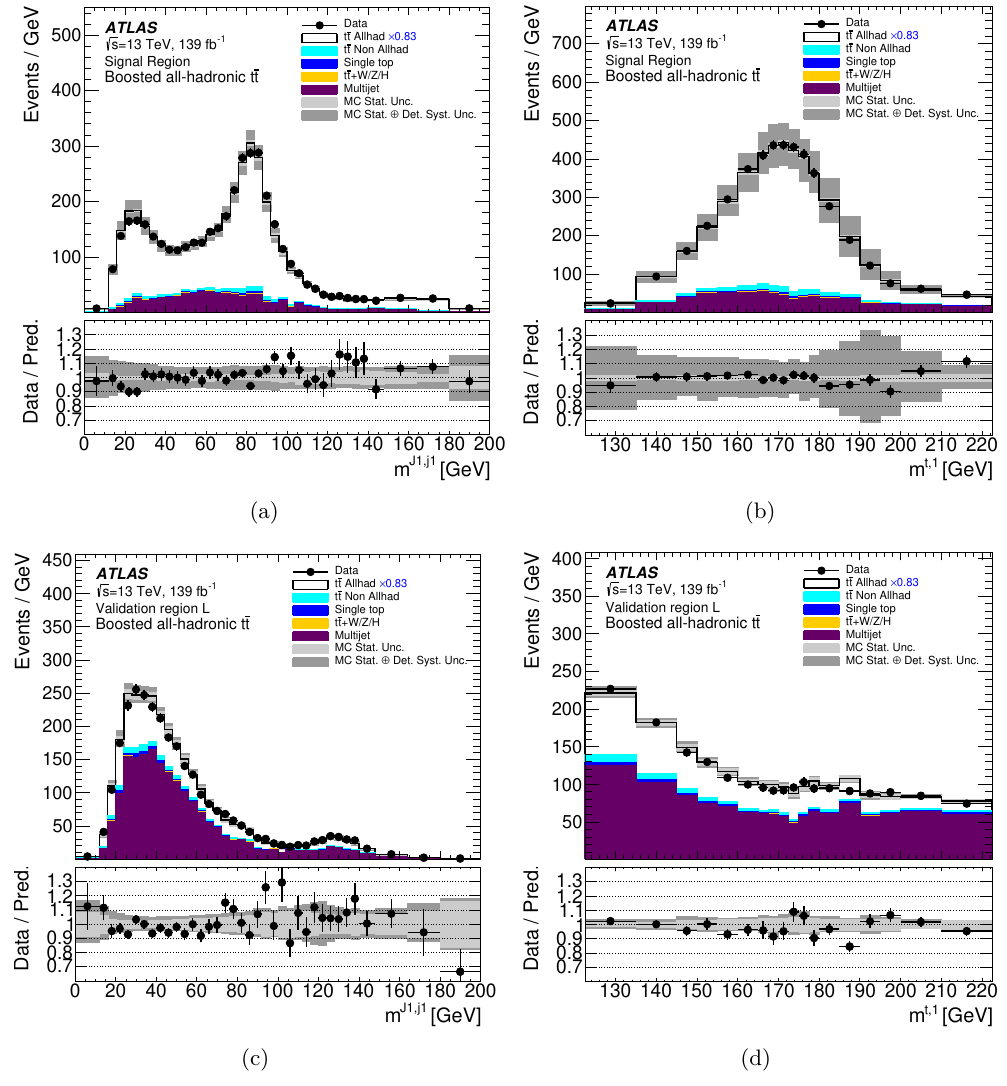
Figure 1 . Kinematic distributions of the leading top-quark-candidate jets in the signal region and validation region L. The mass distributions of the leading R = 0 . 4 anti- k t jet in the leading large- R jet for events in the signal region and region L are shown in (a) and (c), respectively. The leading large- R jet-mass distributions for the events in the signal region and validation region L are shown in (b) and (d), respectively. The signal prediction (open histogram) is based on the Powheg + Pythia 8 t ¯ t calculation normalized to the observed yield in the signal region. The background (solid histogram) is the sum of the data-driven multijet estimate and the MC-based expectation for the non-all-hadronic t ¯ t , single-top-quark, and t ¯ t + W/Z/H processes. The light grey bands indicate the statistical uncertainties and the dark grey bands indicate the combined statistical and detector-related systematic uncertainties defined in section